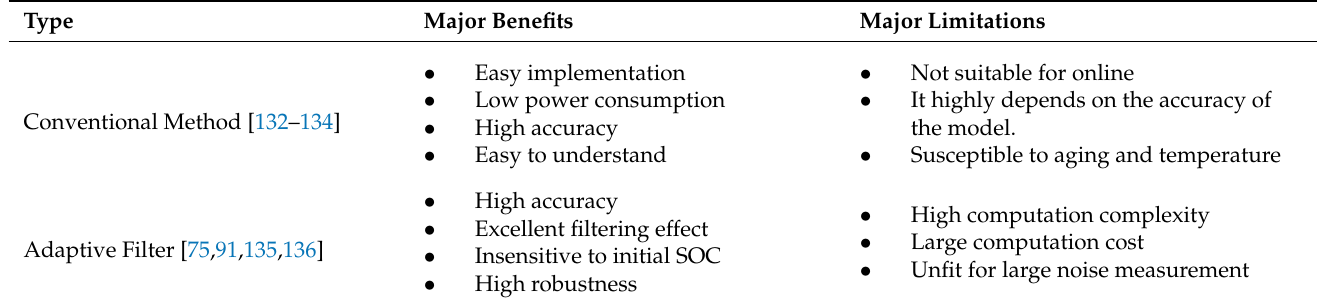
Figure 15. Comparison between the different hybrid SOC estimation algorithms. “A” is referred to as [131], “B” is referred to as [123], and “C” is referred to as [139]. Table 12. Summary of the different SOC estimation methods for Li-ion batteries.